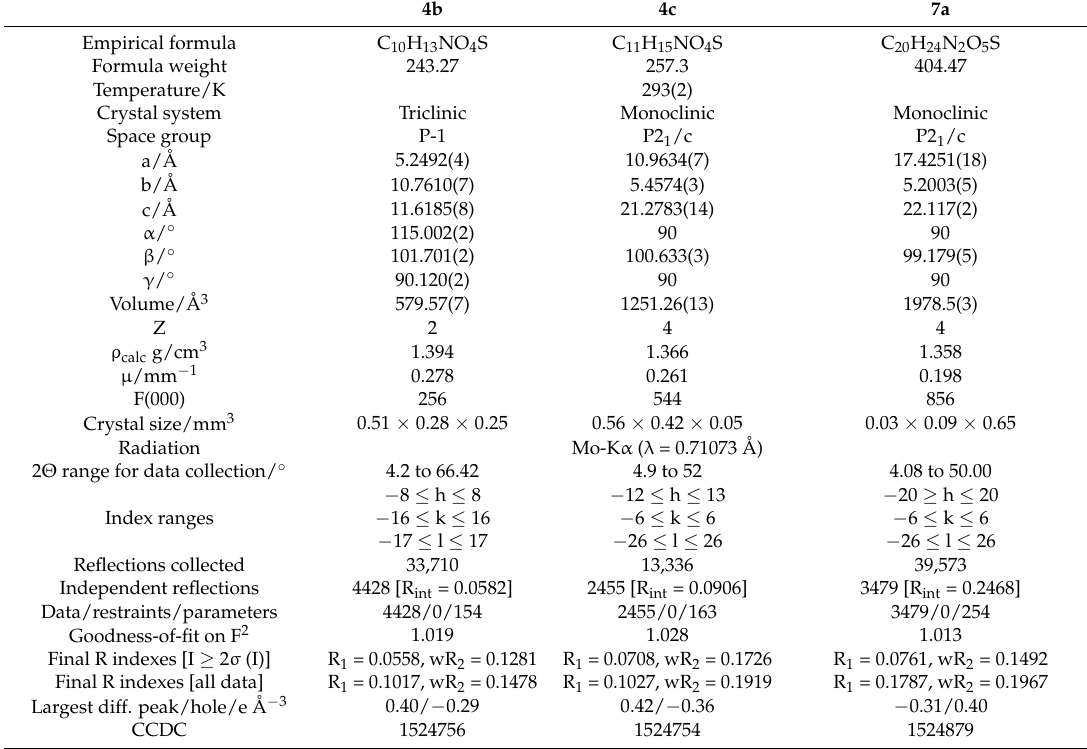
Table 1. Crystal data and structure refinement for the studied